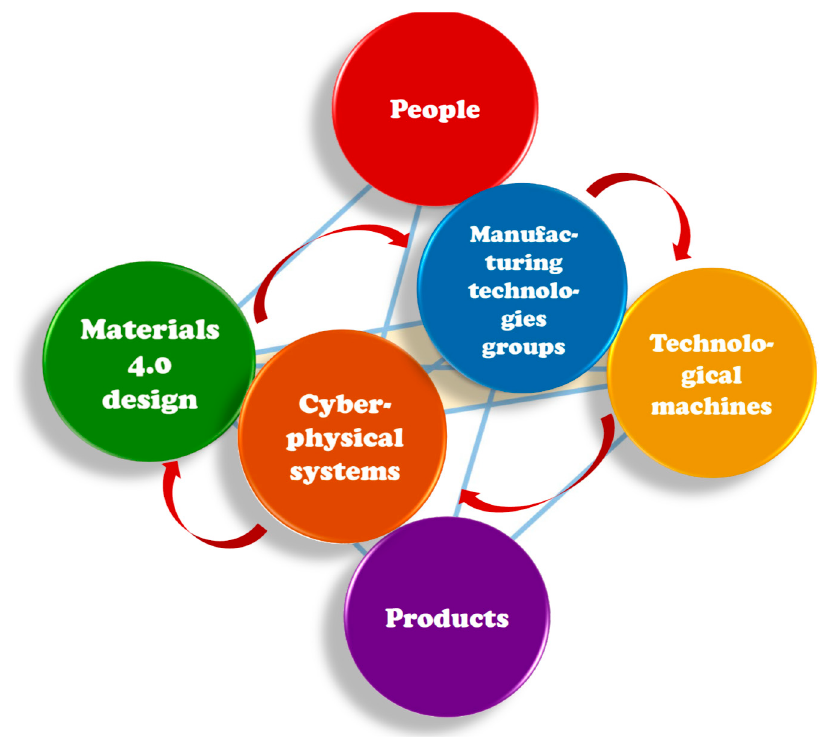
Figure 1. Diagram of the augmented holistic Industry 4.0 model in the form of an octahedron.